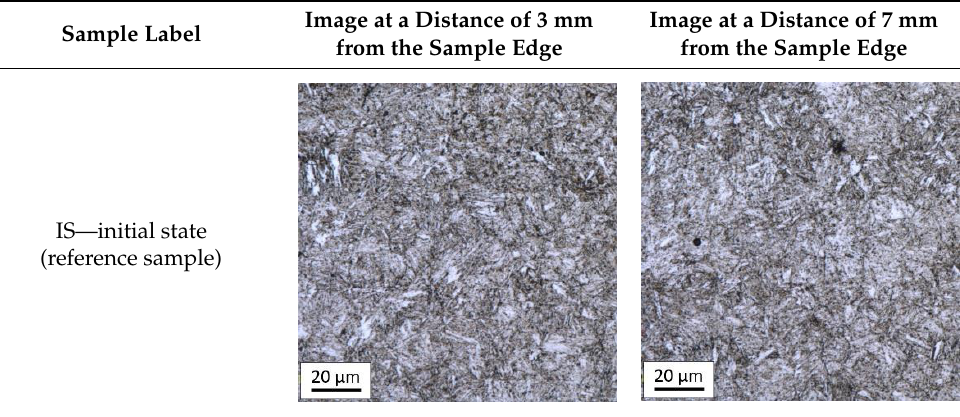
Table 3. Microstructure of steel in its initial state.